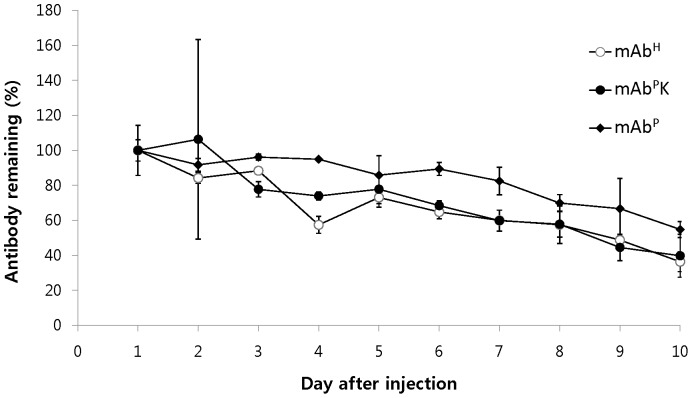
Stability profiles of mAbH, mAbPK and mAbP in mice.The % value was calculated with the formula [100×(concentration of each day/concentration of the first day (24 hr) after injection)], followed up to day 10. The concentration of mAb in the serum from BALB/C mice injected i.p. with mAbH, mAbPK or mAbP was determined by ELISA. Data are presented as means ± SD.